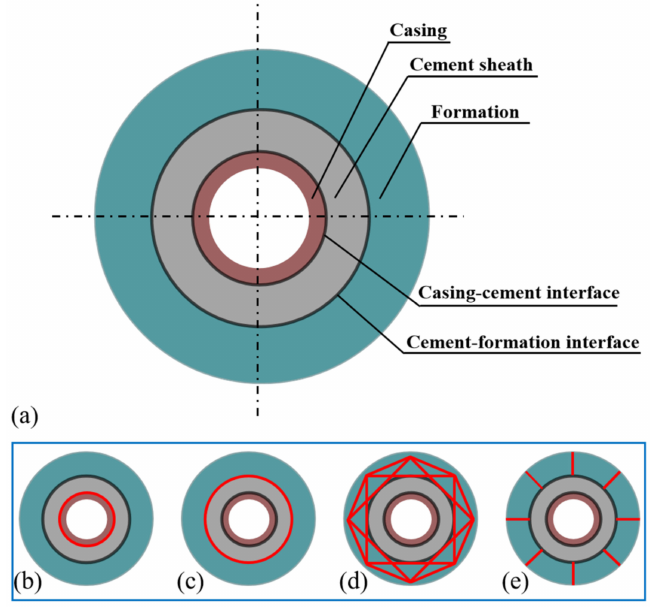
Figure 1. The casing-cement-formation system and the modes of cement sheath damage. ( a ) The composition of casing-cement-formation system, ( b ) casing-cement interface debonding, ( c ) cement- formation interface debonding, ( d ) cement shear damage and ( e ) cement radial tensile